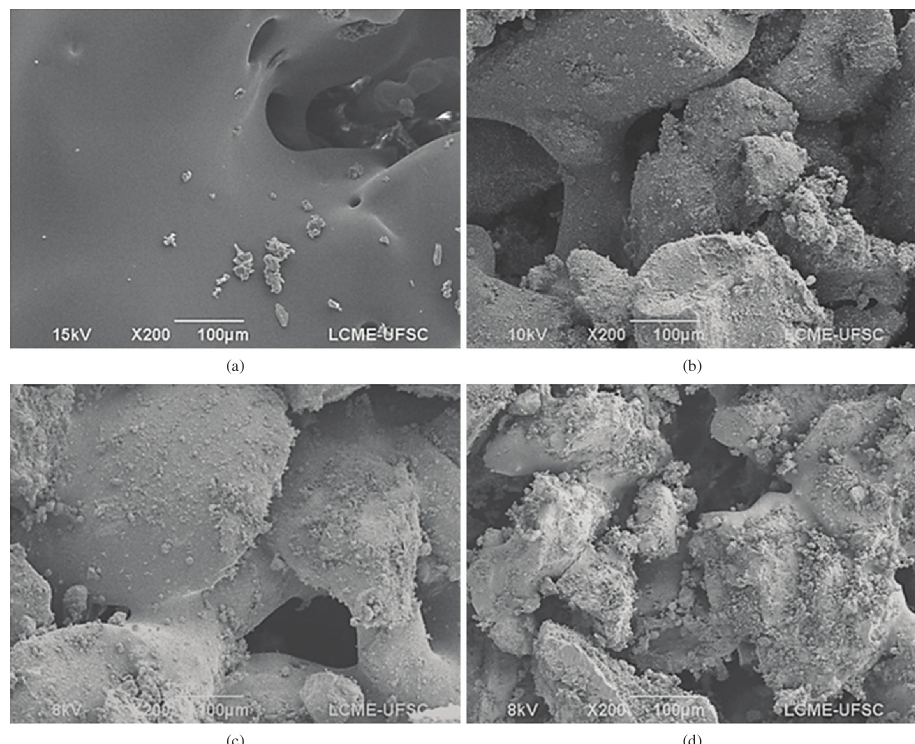
Figure 9. Micrographs with 200x of magnification. a) pure polymer; b) polymer with 10%wt of BG; c) polymer with 20%wt of BG; d) polymer with 30%wt of